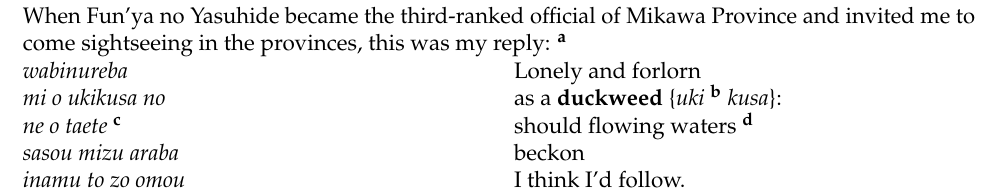
Table 4. A flirtatious poem by Ono no Komachi (adapted and annotated from a translation by A. Commons in